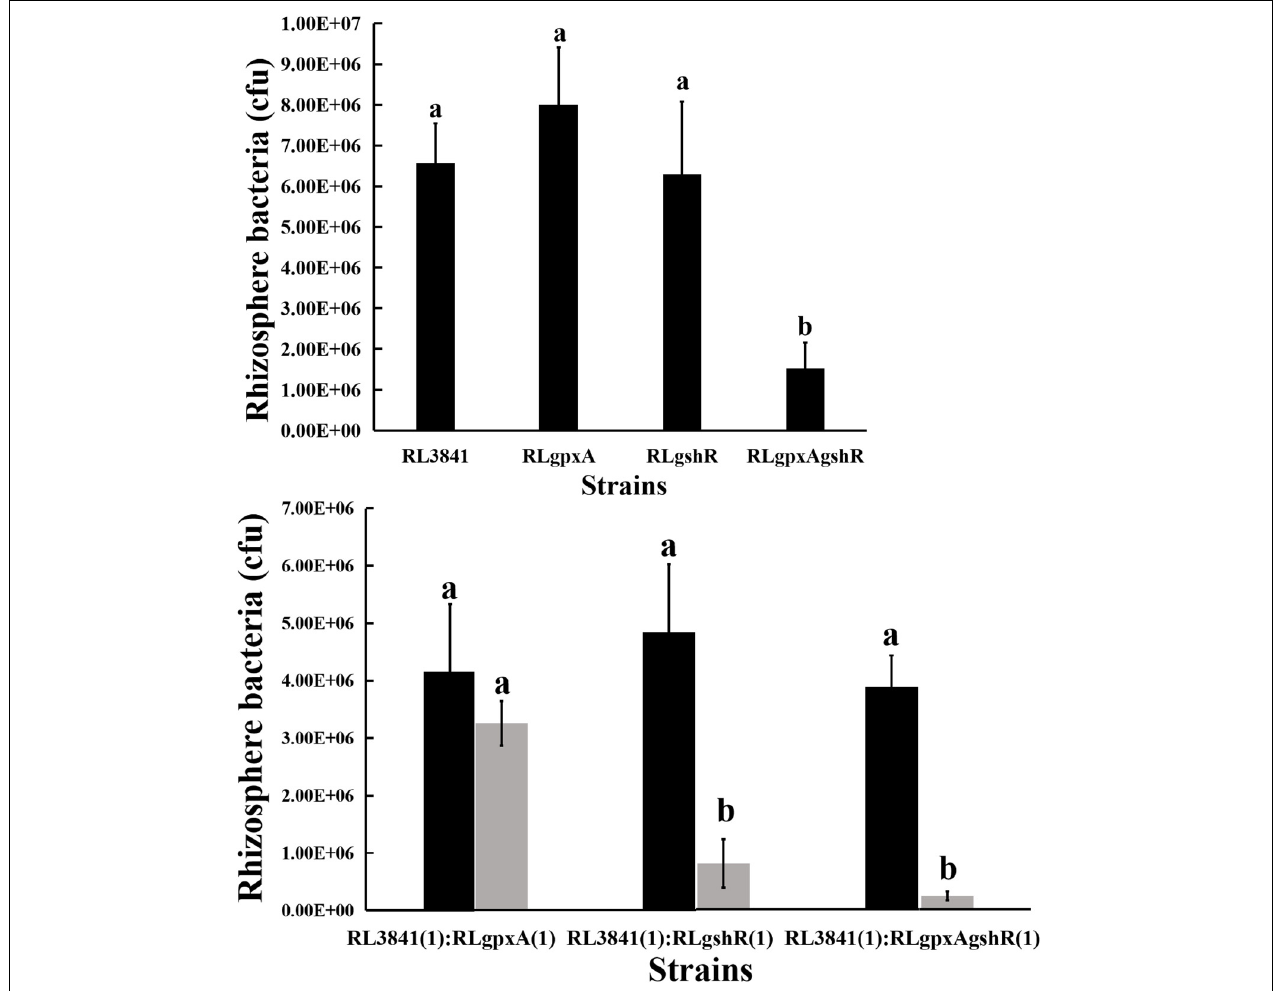
FIGURE 2 | Competition of the wild-type RL3841 (black bars) and the mutants (gray bars) in the pea rhizospheres. The x -axis indicates the initial inoculation ratios, with 1 corresponding to 1 × 10 3 CFU. The number of colony-forming bacteria (per plant) from 10 plants are shown. a , b Values with different letters are significantly different between mutant and wild-type control (two-way ANOVA, P <